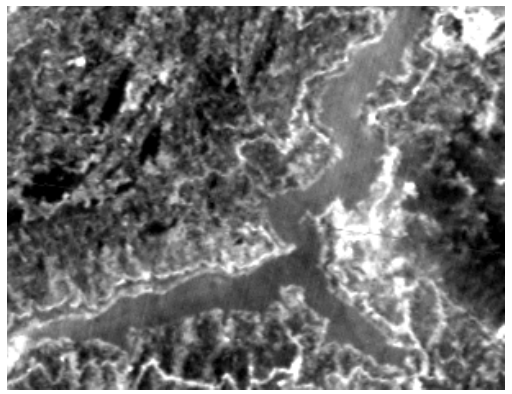
Figure 2. Cbers2 image of Guojiaba Town in Three Gorges.